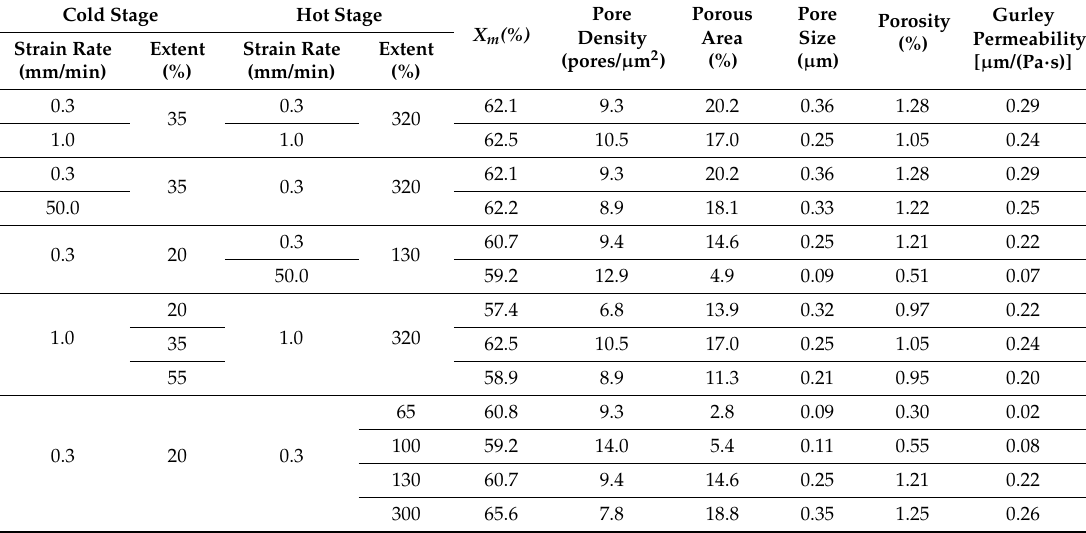
Table 5. Uniaxial strain analysis in terms of orientation, crystallinity, pore morphology and permeability. Gap die 1.9 mm; draw ratio